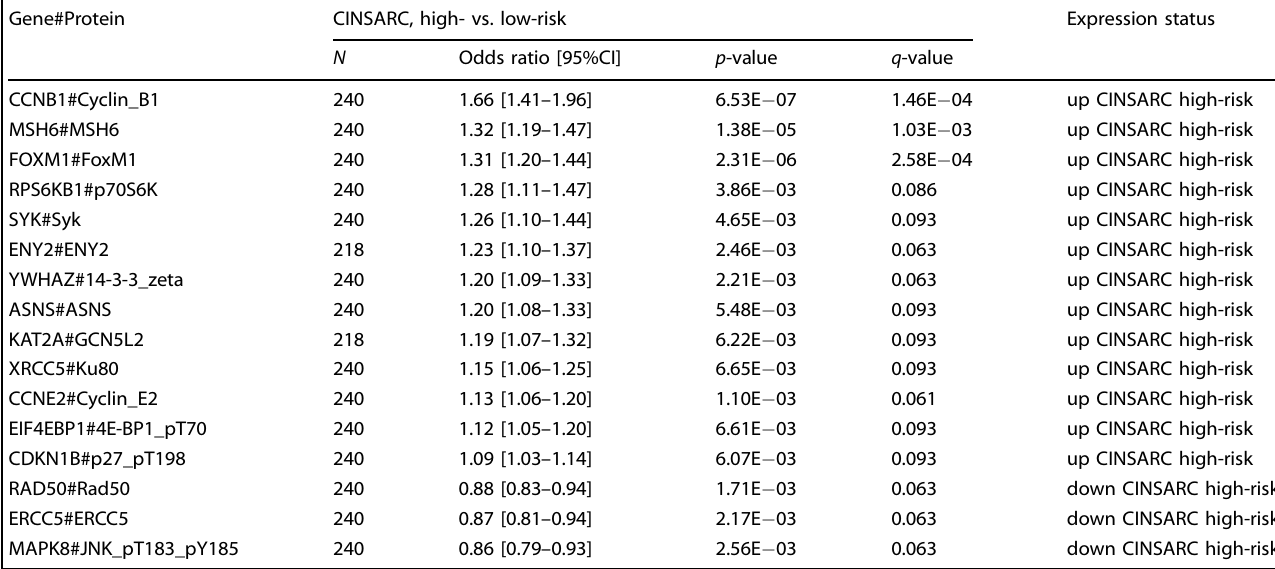
Table 6. List of 16 proteins/phosphoproteins differentially expressed between the two CINSARC classes in Luminal B TCGA breast cancers.